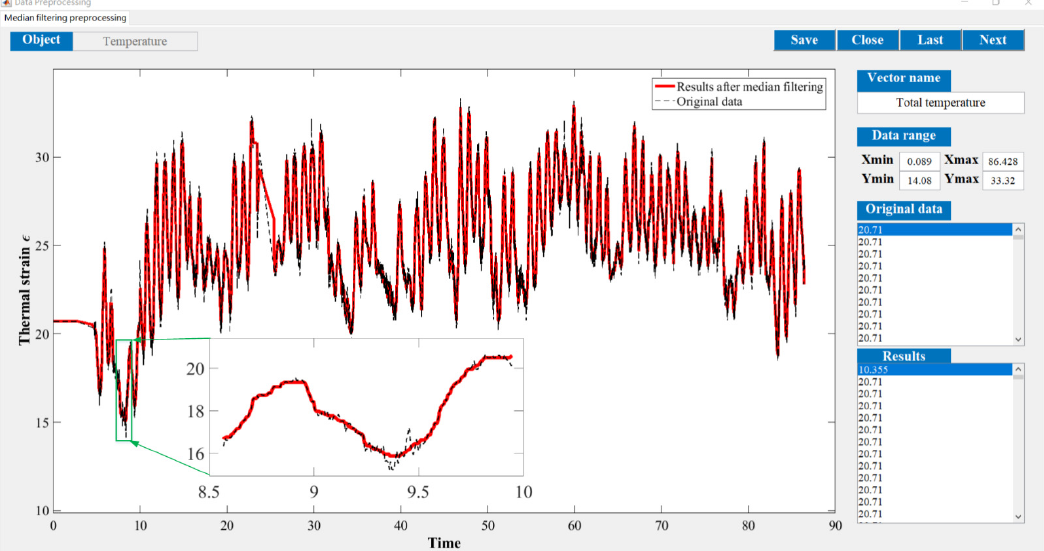
Figure 9. Thermal strains after the median filtering process.